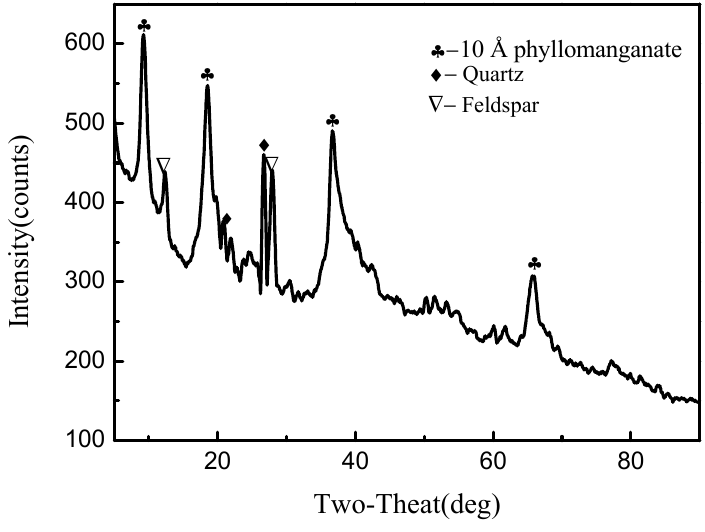
ff raction (XRD) pattern of polymetallic Figure 1. X-ray diffraction (XRD) pattern of polymetallic nodules. Figure 1. X-ray di